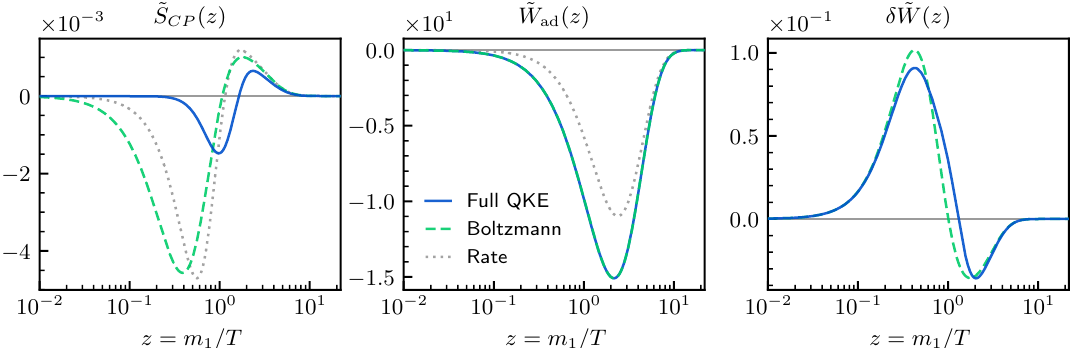
Figure 6. Numerically calculated CP-violating source term ˜ S CP ( z ) and the washout term coeffi- cients ˜ W ad ( z ) and δ ˜ W ( z ) of our main lepton equation (6.11) (solid line), Boltzmann equation (G.6) (dashed line) and rate equation (G.20) (dotted line). We used the benchmark parameter values (7.7) and vacuum initial